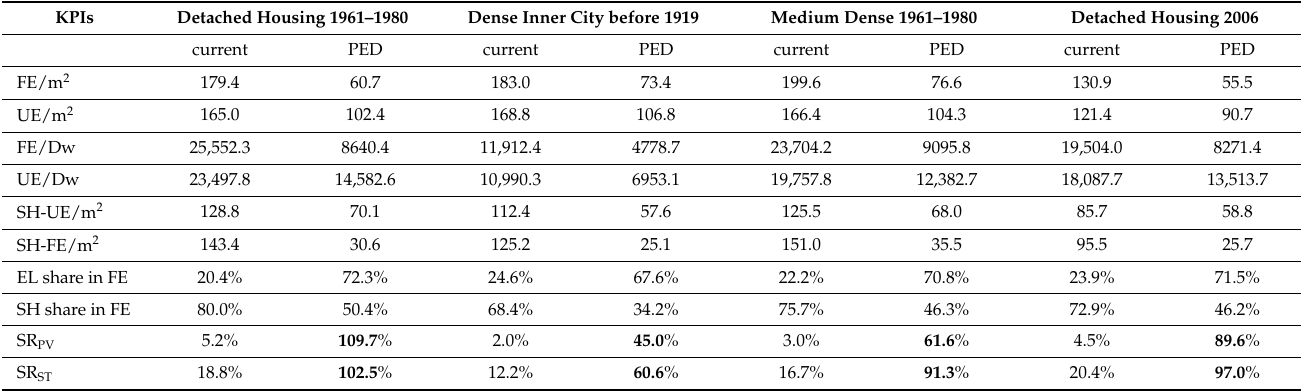
Table 3. Key performance indicators (KPIs) for evaluating the energy demand-supply features of the selected typologies and their capability to become a PED.